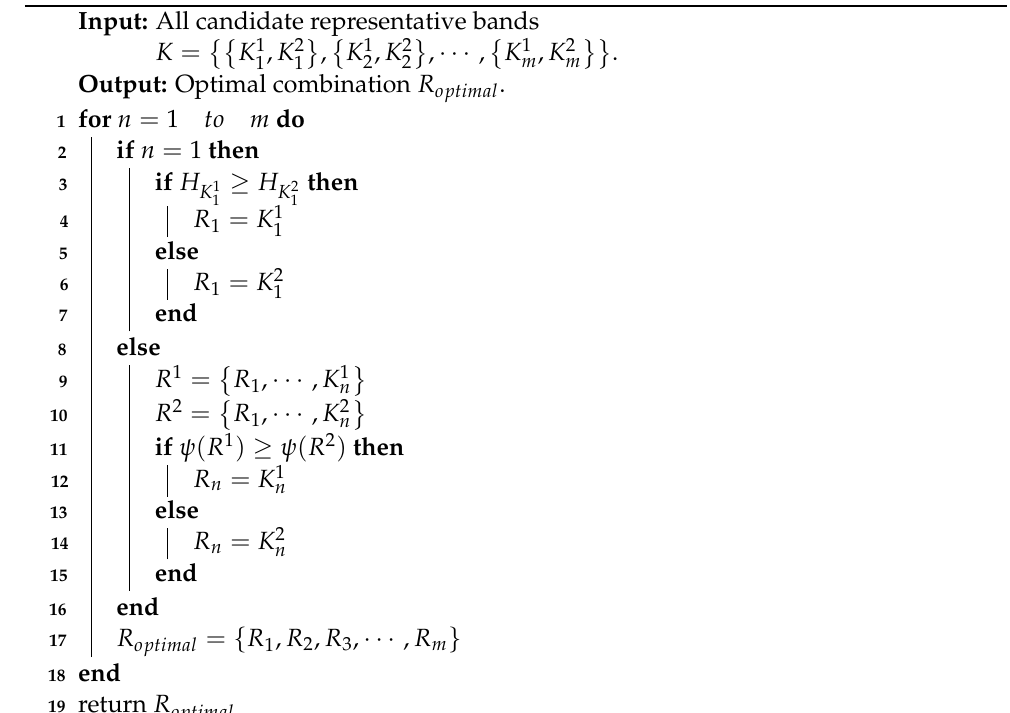
Algorithm 1: Optimal combination